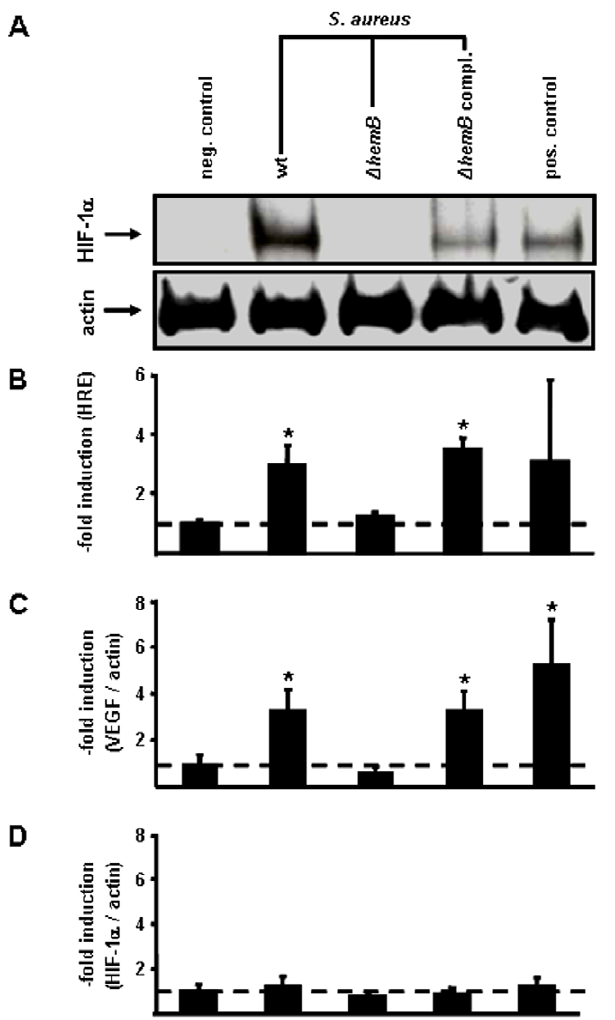
Figure 4. Induction of HIF-1-dependent gene programming in HeLa-229 cells by different S. aureus strains. Six hours upon infection, HIF-1 activation was analyzed in (A) Western blots (loading control: actin) and by determining (B) the induction of the HIF-1- dependent luciferase activity. HeLa-229 cells were transfected with a 4xHRE-luc reporter construct 24 hours before infection (triplicate means given; for details see Material and Methods). Induction was determined by chemiluminescence. Bacterial induced (C) VEGF and (D) HIF-1 a transcription. Total mRNA was prepared six hours upon infection, transcribed into cDNA and quantified by real-time Light-Cycler-PCR (ratio: VEGF/actin or HIF-1 a /actin transcripts; triplicate means given). Negative control: uninfected cells; S. aureus wt (8325-4); S. aureus D hemB ( S. aureus ermB V hemB 8325-4, SCV); S. aureus D hemB , hemB - complemented ( S. aureus pCX19 V hemB 8325-4, complemented SCV mutant) [16]; positive control: DFO (200 m mol/L). Multiplicity of infection (MOI): 20. * significant difference to control cells (P , 0.05).